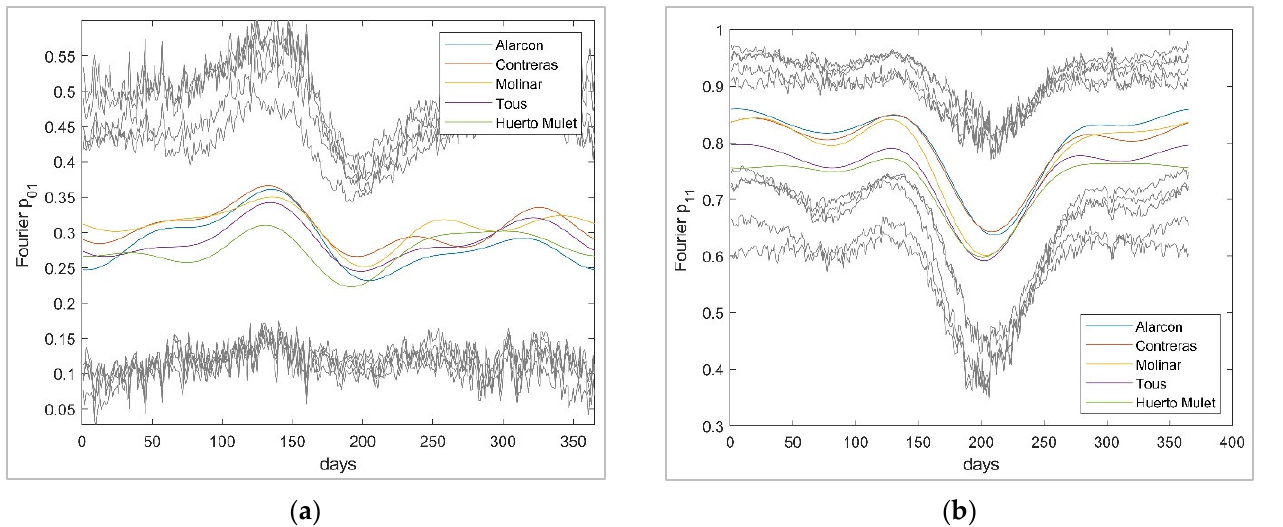
Figure 3. Fourier series and confidence limits for Alarcon: ( a ) p 01 ( b ) p 11 with four parameters. Confidence limits at 95% (lower and upper limits).